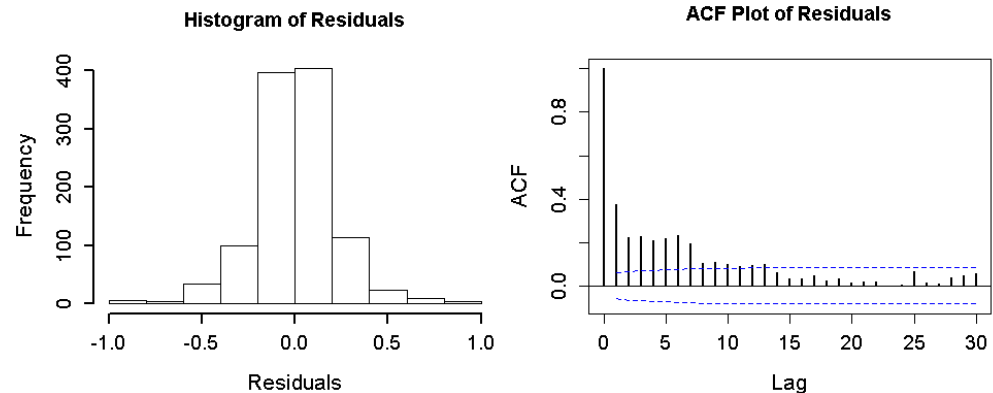
Figure 4. Plots of histogram and autocorrelation function (ACF) of the residuals from the constructed model to check the validity of the multi-pollutant model. The blue lines represent the confidence interval lines with a 95% coverage probability.